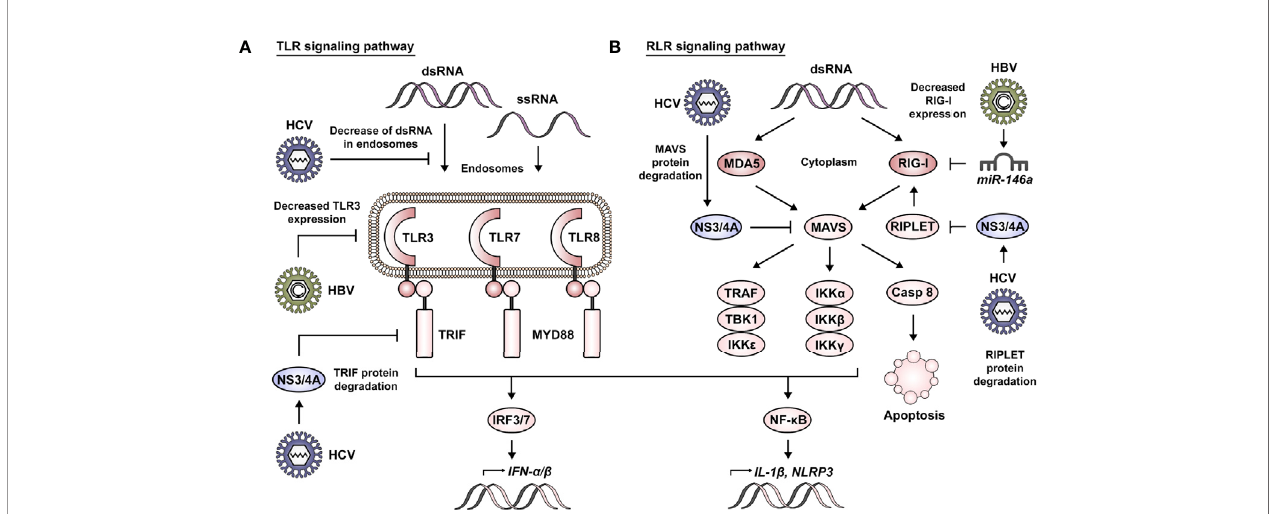
FIGURE 1 | RNA sensing and viral manipulation of TLR and RLR signaling pathways. (A) Foreign RNA sensing is mediated by TLR3, 7, and 8 in the endosomal compartment. These signals are transduced via TRIF in the case of TLR3 and by intermediary of MYD88 for TLR7 and TLR8. Their activation leads to the production of type I IFNs via IRF3/7 and to the expression of other genes such as IL-1 b and NLRP3 via the NF- k B pathway. HBV has been reported to impair TLR signaling pathways via decreased expression of TLR3. Similarly, HCV affects TLR signaling by decreasing the presence of dsRNA in endosomes and via NS3/4A-mediated degradation of TRIF. (B) Foreign RNA sensing is mediated by MDA5 and RIG-I in the cytoplasmic compartment. K63-linked ubiquitination of RIG-I by RIPLET is necessary for its activation. MDA5 and RIG-I signals converge in the activation of MAVS and are carried via TRAF, TBK1 and IKK ϵ for the induction of IFNs, or via IKK a , IKK b , and IKK g for induction of the NF- k B pathway. Alternatively, MAVS signaling can also induce apoptosis via activation of caspase 8. HBV has been reported to impair RLR signaling pathways via miR-146a – mediated downregulation of RIG-I. Similarly, HCV affects RLR signaling via NS3/4A-mediated degradation of RIPLET and